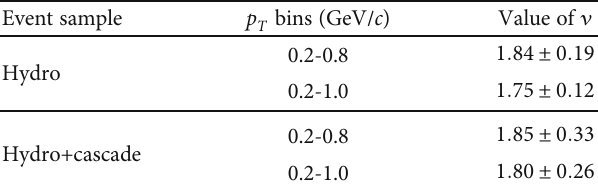
Table 1: Scaling index values of the event samples.